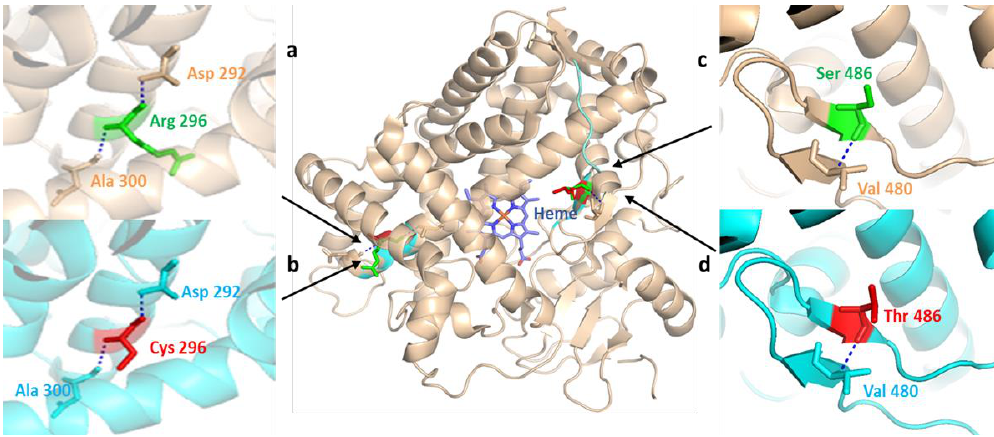
Figure 6. Structural comparison of human CYP2D6 (PDB: 2F9Q) to the mutant CYP2D6 protein depicting normal and missense mutation sites reported in the Pakistani population. Wild-type CYP2D6 is represented in wheat, while mutant-type is represented in cyan. Positions of normal (green) and mutant (red) amino acid residues are indicated by black arrow heads. ( a ) the hydrogen interactions of wild-type Arg296 residue to peptide backbone Asp292 and Ala300 residues; ( b ) X-ray structure partial view of missense SNP produced by in silico mutagenesis through the substitution of positively charged polar Arg296 with the relatively smaller nonpolar Cys296 residue; ( c , d ) highlight hydrogen bond interactions of wild-type Ser486 and mutant Thr486 amino acids with the adjacent Val480 residue in peptide backbone, represented in wheat and cyan, respectively.